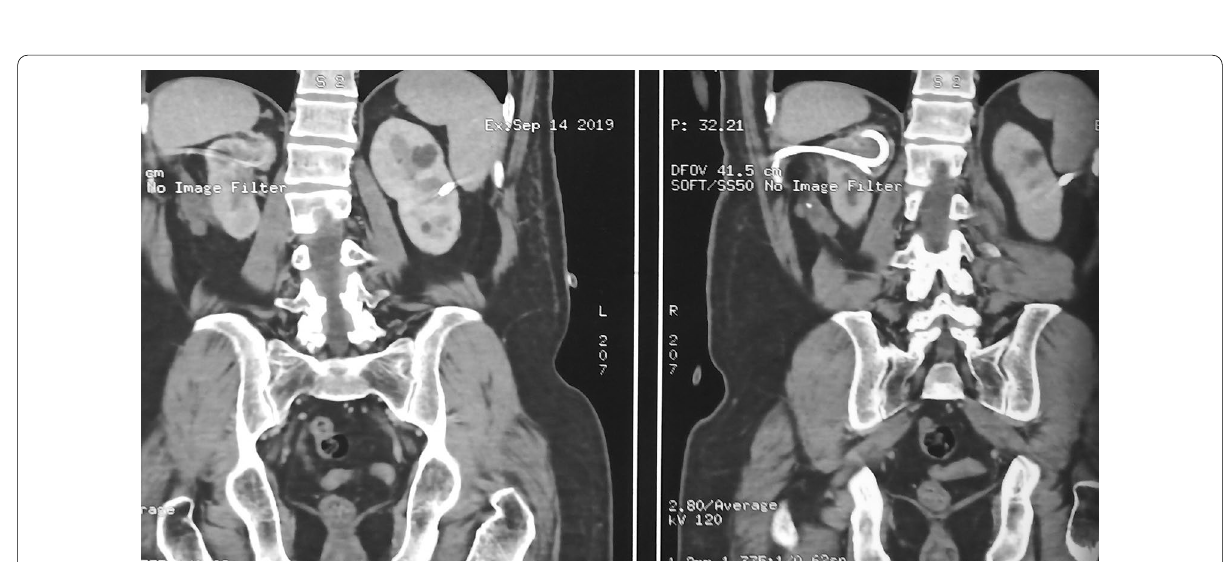
Fig. 2 CECT whole abdomen showing right small kidney and left normal kidney with bilateral PCN in situ with thimble